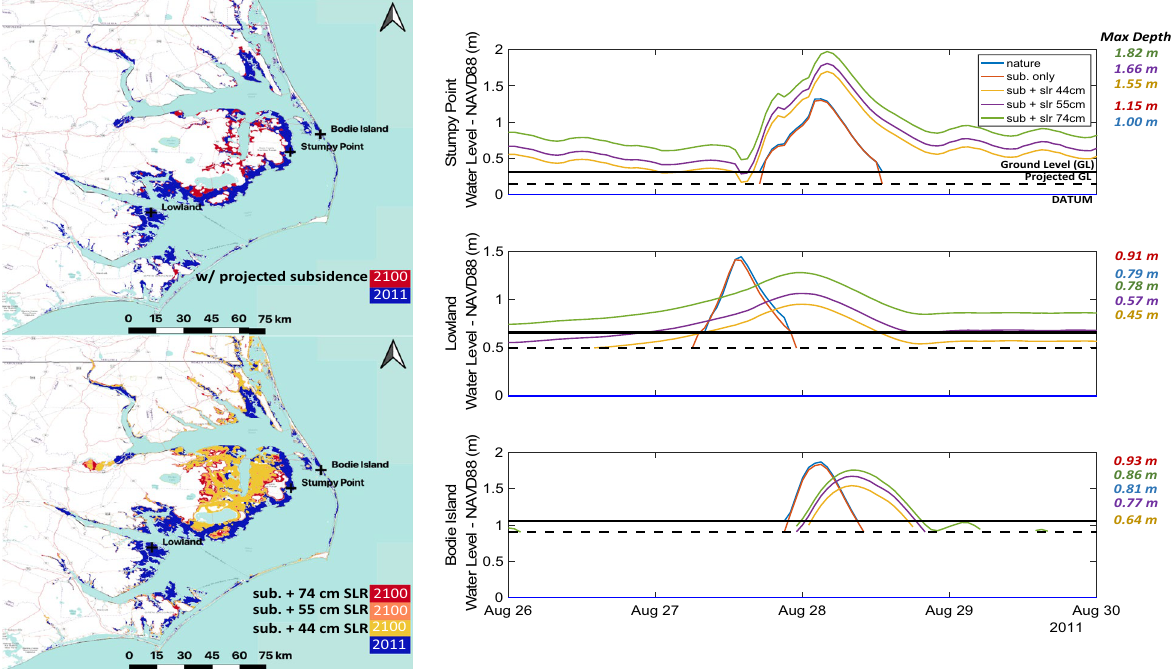
Figure 5. Hurricane Irene flood extent and water level timeseries at indicated focus node locations including Bodie Island, Stumpy Point, and Lowland, NC. Results summarized in Table 2. Figure created in QGIS (Version 3.16, https:// qgis. org/ en/ site/ forus ers/ downl oad. html) using ESRI Transportation and Terrain